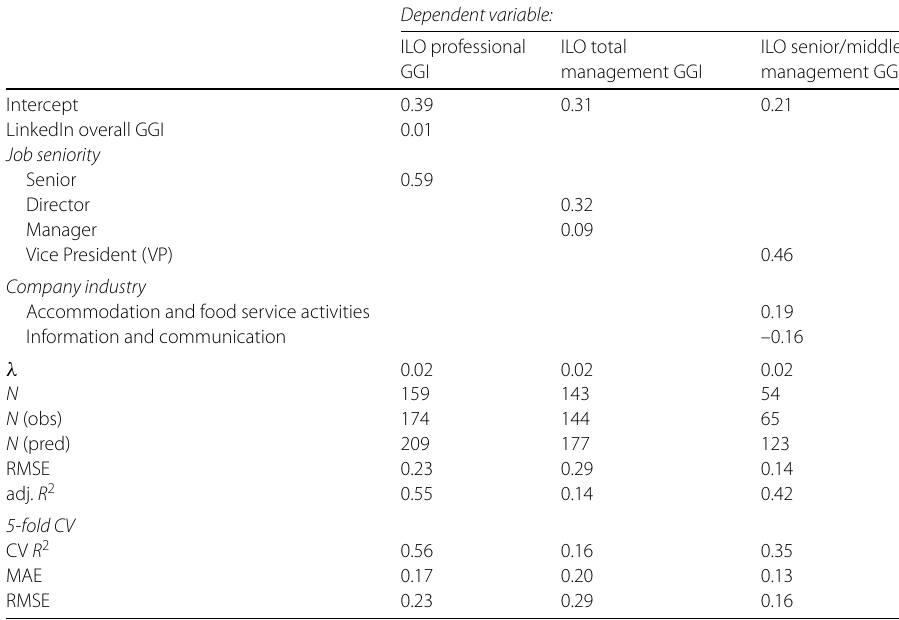
Table 5 Regression coefficients for model predicting ILO GGIs (variables selected using lasso regression and λ min